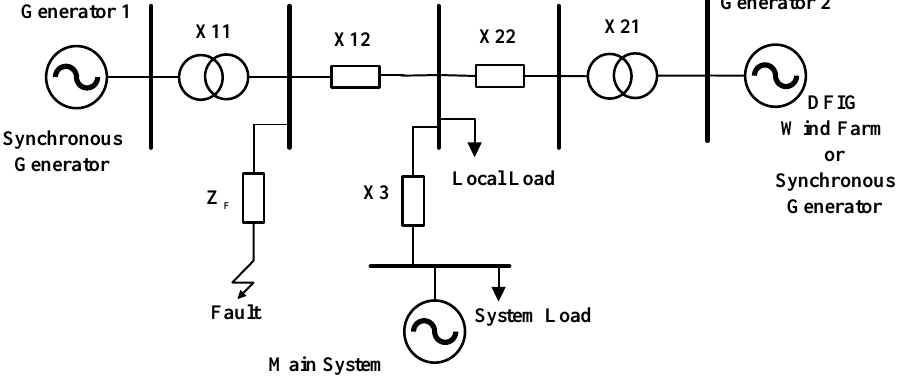
Figure 4. Standard network model employed for the transient performance test.